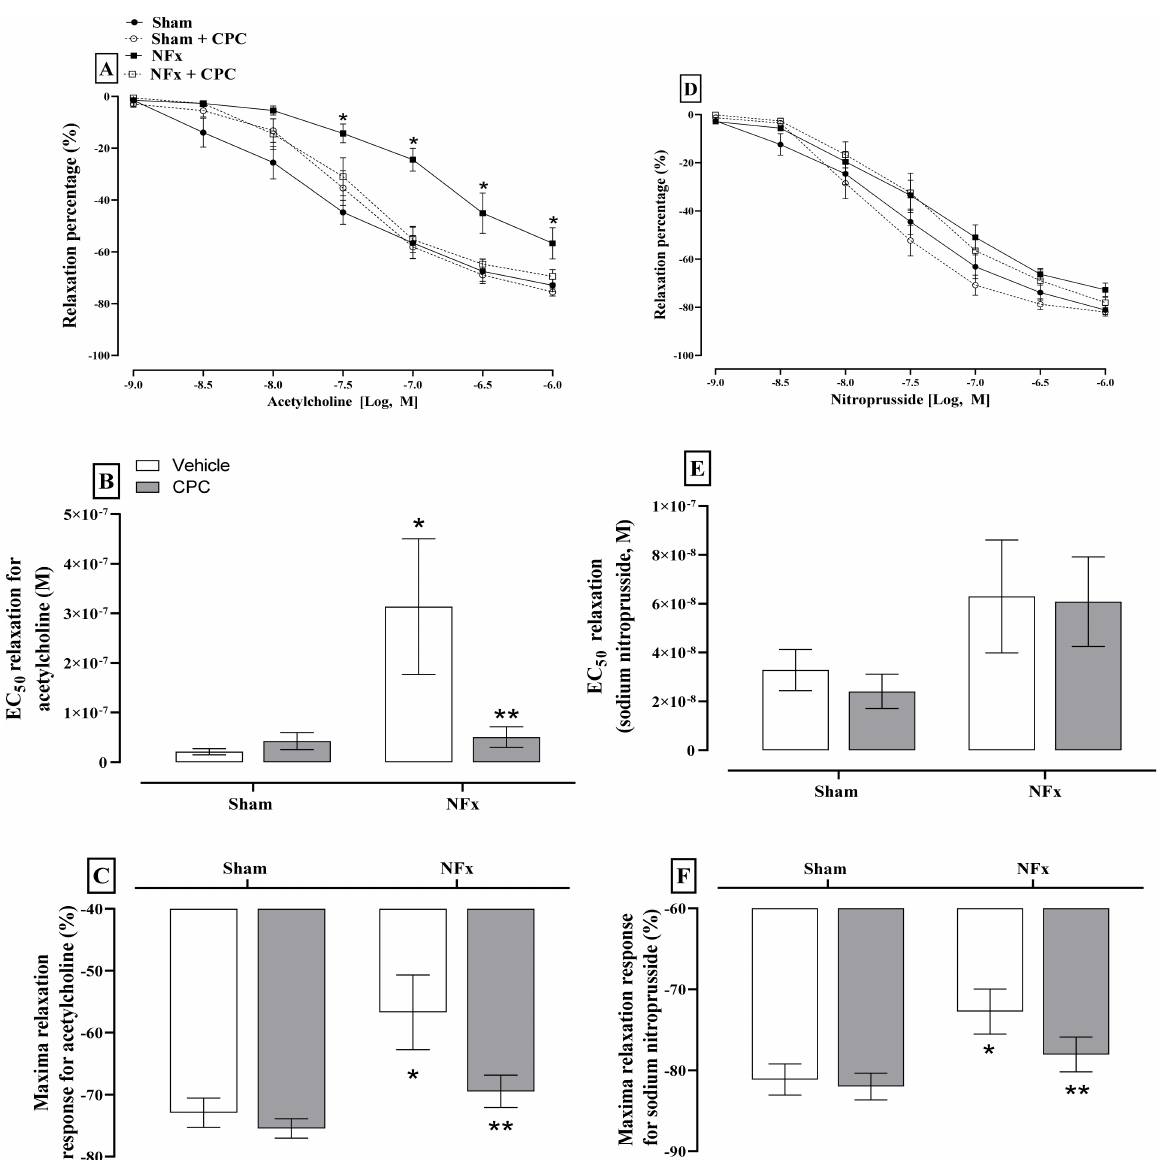
Figure 3. Effect of C-phycocyanin on endothelium and muscular functions of aorta rings of 5/6 nephrectomized rats. ( A – C ) show the acetylcholine relaxation response, and ( D , E ) show the sodium nitroprusside relaxation response. Values represent the mean ± SEM. In ( A , D ) (*) p < 0.05 compared to the sham + vehicle at the same concentration. RM Two-way ANOVA and SNK post hoc